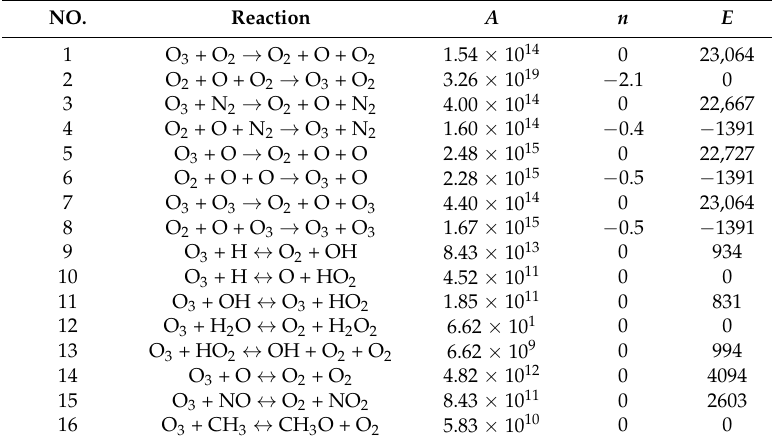
Table 1. Sub-mechanism for ozone decomposition